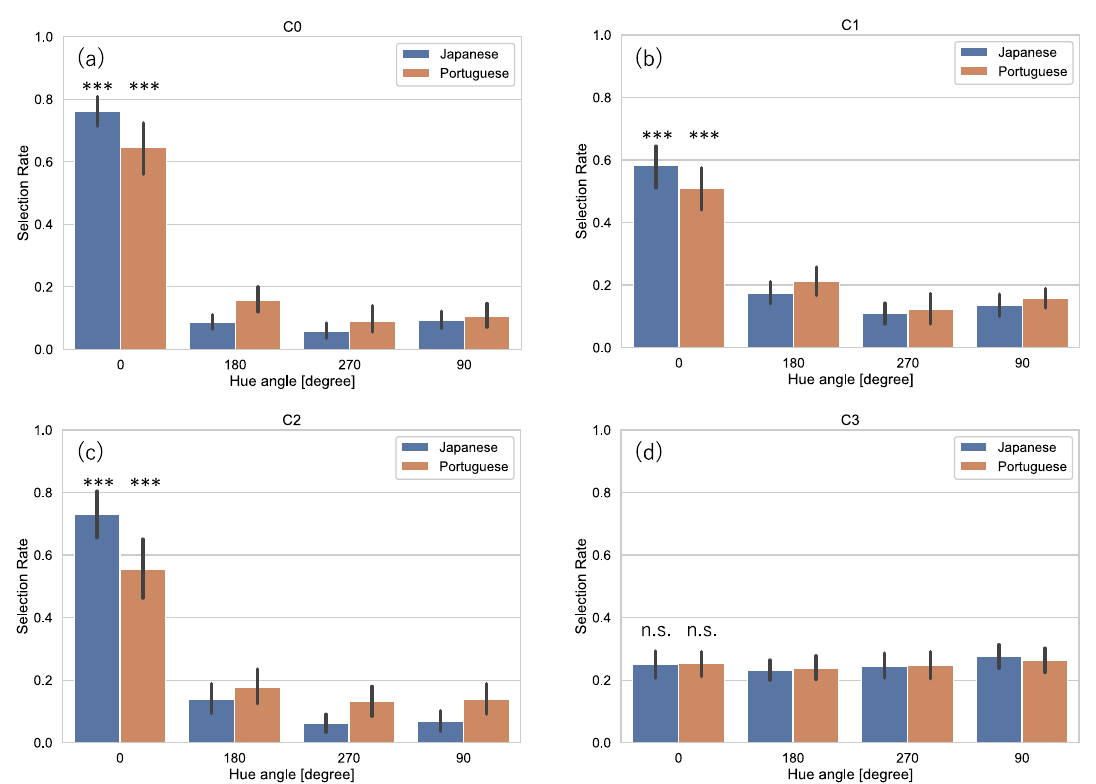
Figure 4. Average selection rates for original (0 degrees) and 90, 180, and 270 degrees hue‑rotated images for Japanese and Portuguese observers measured in the main experiment. Selection rates measured in ( a ) C0 in which images were manipulated only with hue rotation, ( b ) C1: Scrambled, ( c ) C2: Patchwork, and ( d ) C3: Randomized conditions. Bars represent 95% confidence intervals. Asterisks indicate a significant difference from chance level; *** p <